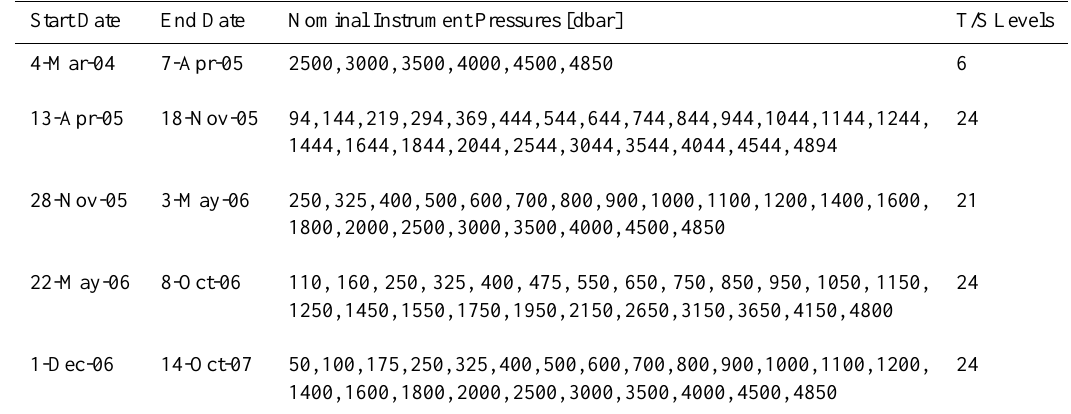
Table 2. Periods of mooring records and nominal pressure levels of sensors of EB1 mooring.